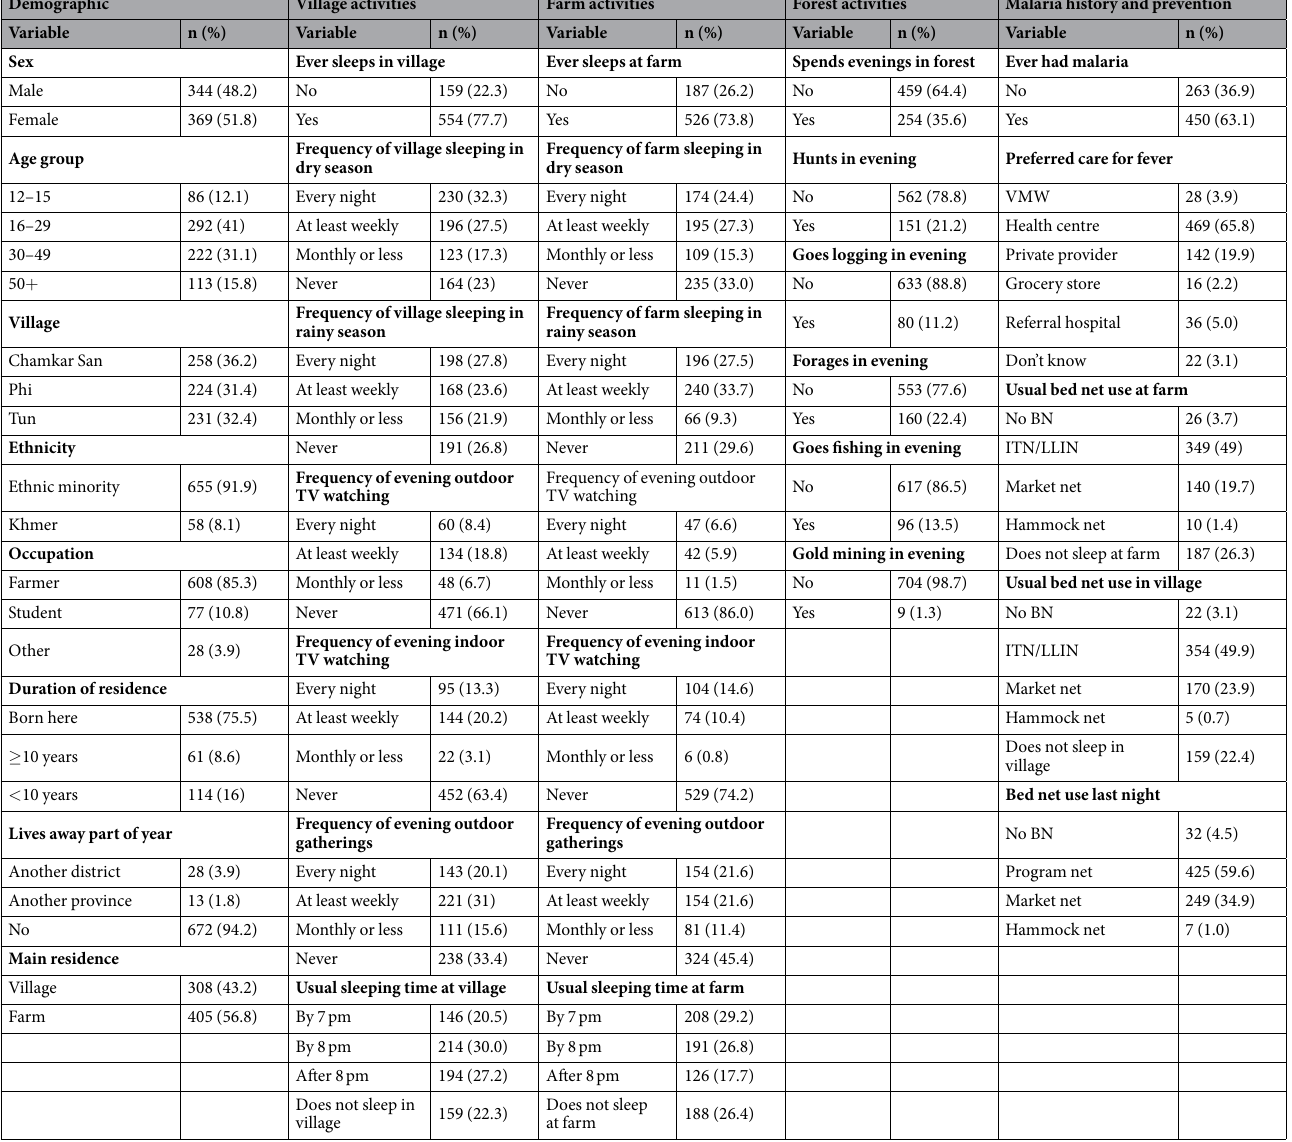
Table 3. Individual-level characteristics of 713 adolescent and adult individuals participating in the cross- sectional